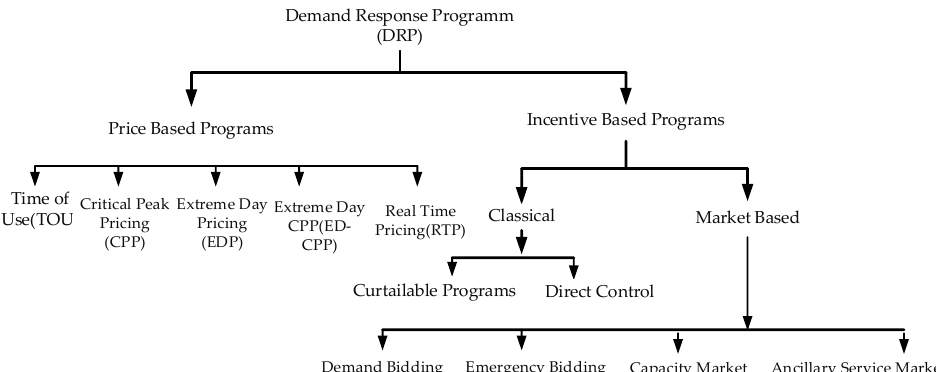
Figure 2. Demand Response.